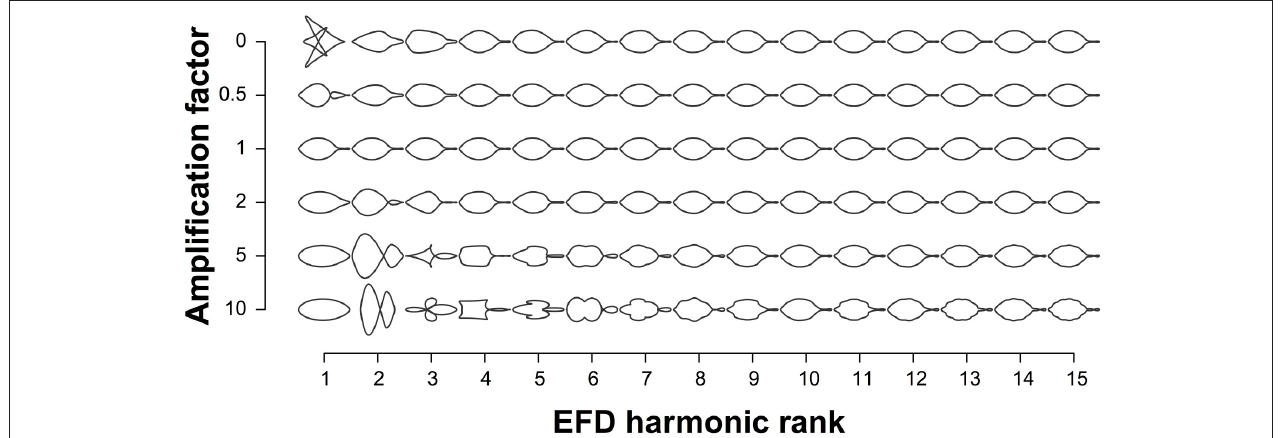
FIGURE 2 | Contribution of elliptical Fourier descriptor harmonics to leaf shape. The leaf shapes depicted are the mean leaf shapes based on all 915 trees. Harmonics 1–15 are represented on the x-axis and each harmonic is multiplied by the amplification factor on the y-axis to visualize their contribution to mean leaf shape. An amplification factor of 0 indicates the removal of the harmonic; a factor of 1 results in the normal shape; and values above 1 exaggerate effects to better visualize the harmonic’s contribution to the final